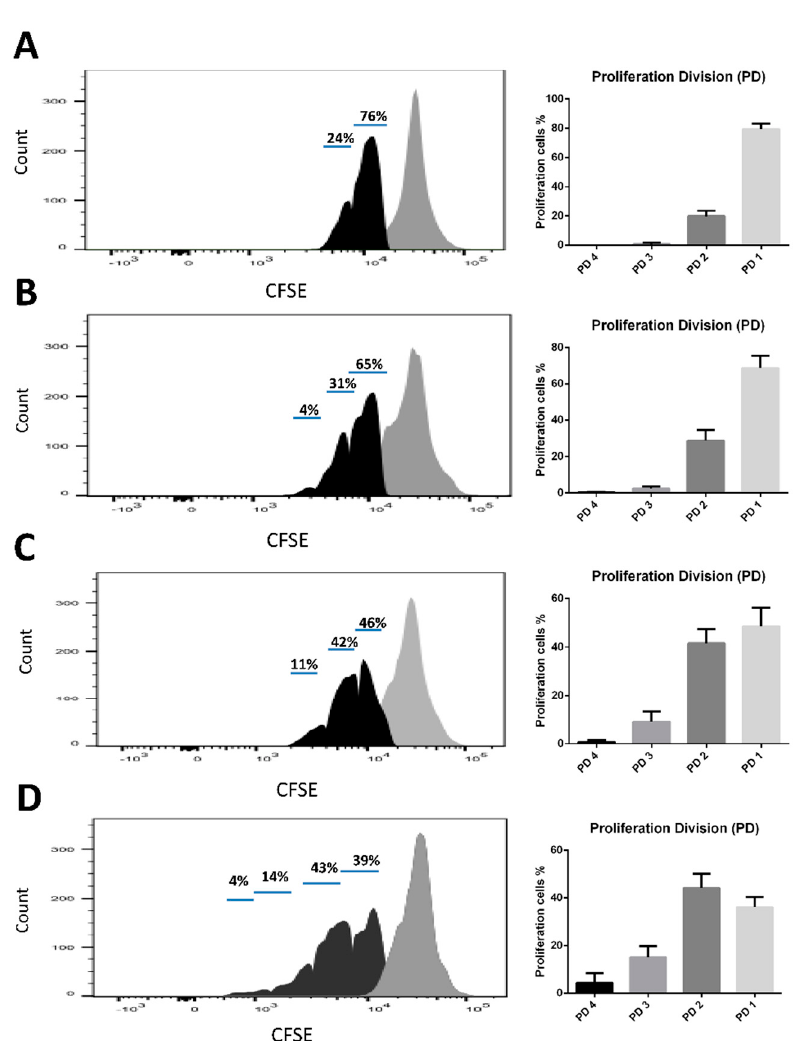
Figure 8. Cell proliferation of splenocytes after ex vivo stimulation. Carboxyfluorescein succinimidyl ester (CFSE)-labeled splenocytes were treated with 100 µg/mL OVA antigen for 3 d. The decrease in fluorescence intensity was examined by flow cytometry. ( A ) Phosphate-buffered saline (PBS), ( B ) decellularized lymph node (dLN), ( C ) bone marrow dendritic cell (BMDC), and ( D ) BMDC-dLN groups.